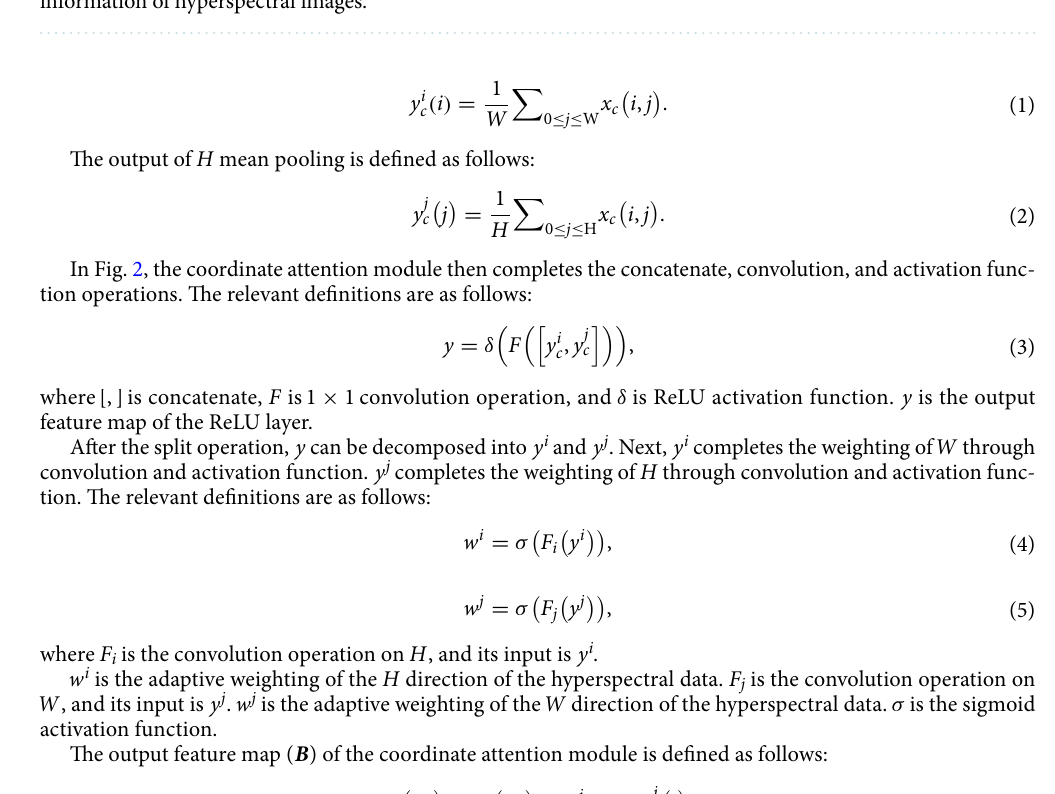
Figure 2. Coordinate attention module. The coordinate attention module can accurately capture the coordinate information of hyperspectral